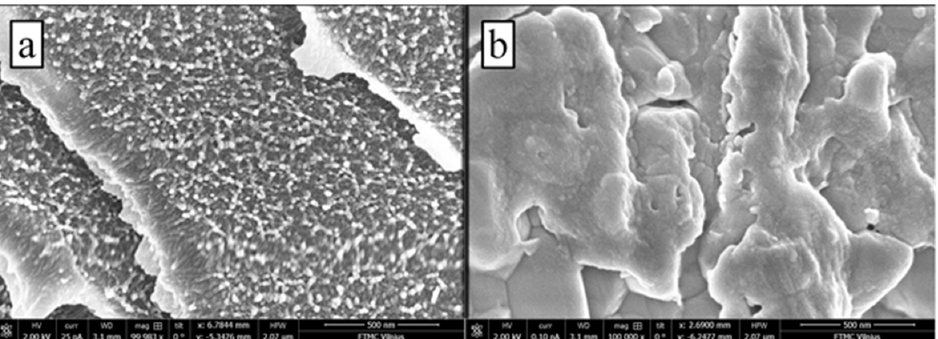
Figure 2. SEM images of ( a ) PAM-G and ( b ) PAM-G cast with 1 M KCl. Both gels were cast from 40% PAM concentration solution. Both images were taken at 10 5 magnification. PAM-G were made up from nano sized (~15 nm) spherical structures, while PAM-G + KCl from monolithic folds.